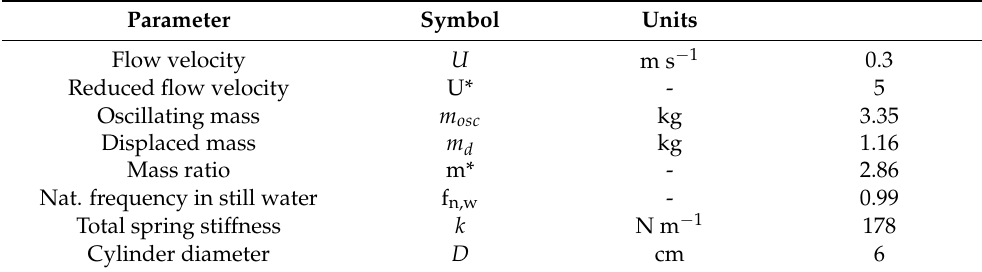
Table 1. Parametric details of the